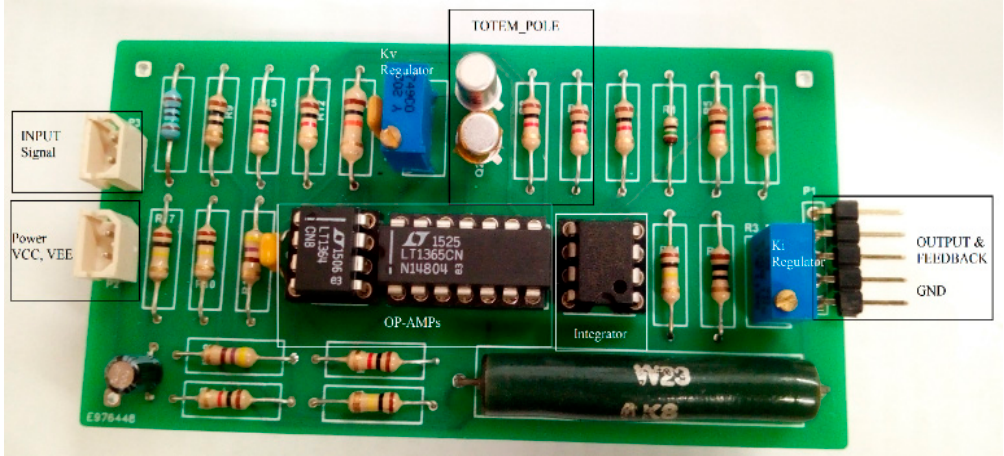
Figure A3. AGD prototype manufactured.